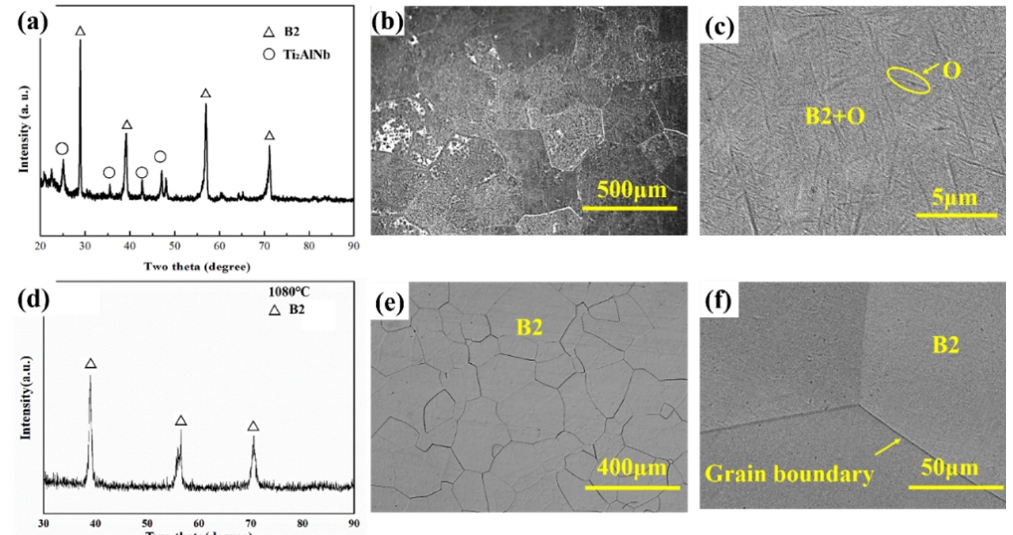
Figure 3. Initial microstructure ( a – c ) and the one after solution treatment at 1080 °C for 15 min ( d – f ) for the rolled Ti-22Al-25Nb alloy. ( a , d ) XRD patterns, ( b , e ) optical microscopy (OM) images, ( c , f ) back-scattered electron (BSE) images.